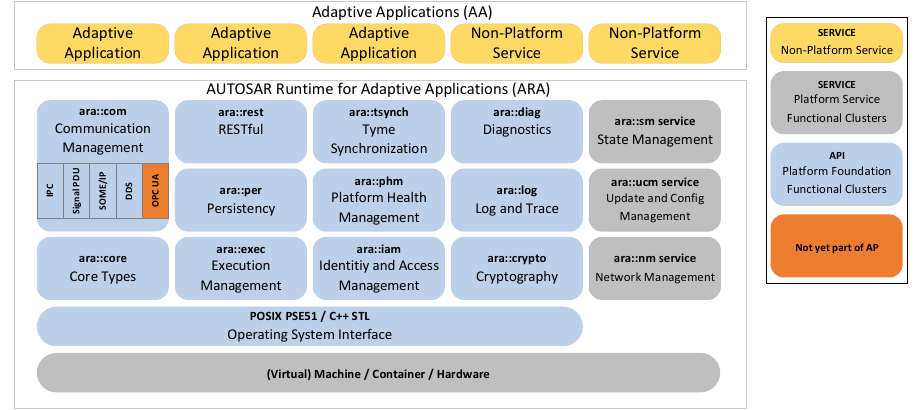
Figure 2. Logical view of Adaptive Platform (AP) architecture including the OPC UA binding, see ([5] Figure